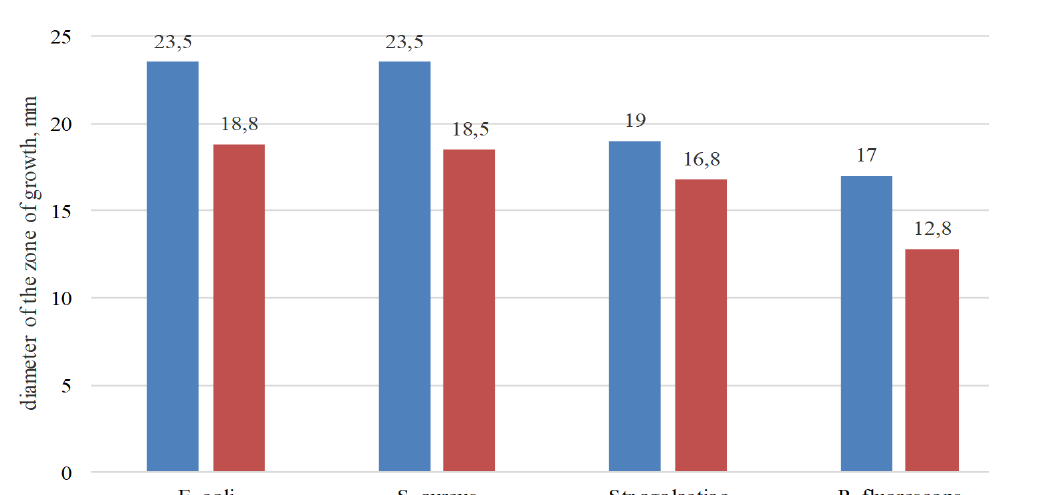
Fig. 1. Comparative analysis of the antimicrobial activity of the drug “Ointment for wounds” and “Clindamycin ointment 2 %” (Clindamycin ointment 2